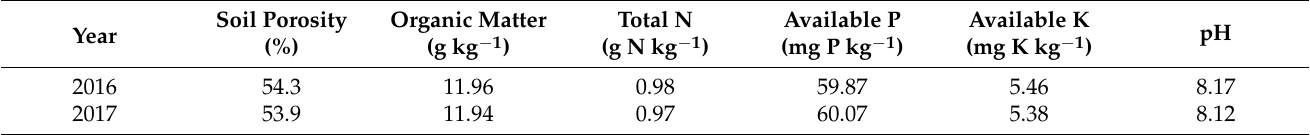
Table 1. Soil porosity and chemical characteristics of the soil of the experimental site.